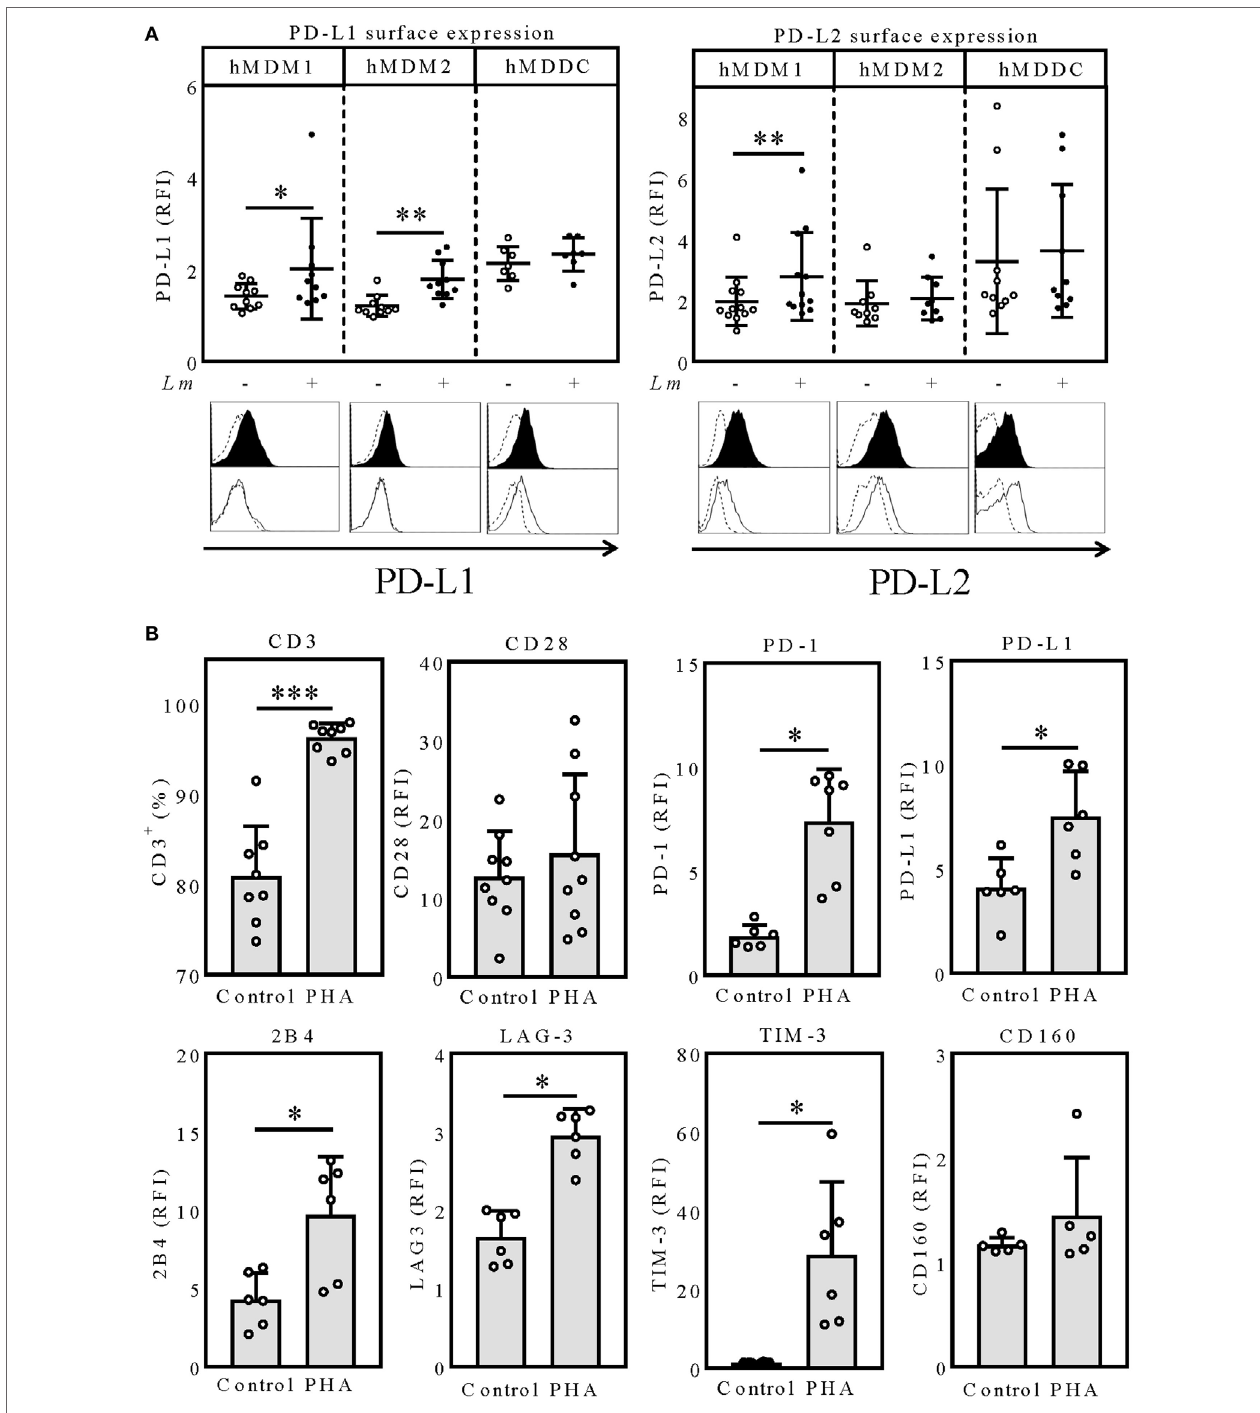
used PBLs PHA (containing PD­1 + T­cells) in autologous cocultures with the three Lm host cell types (PD­L1 + and PD­L2 + ) to inves­ tigate how T­cell effector functions are affected by nivolumab